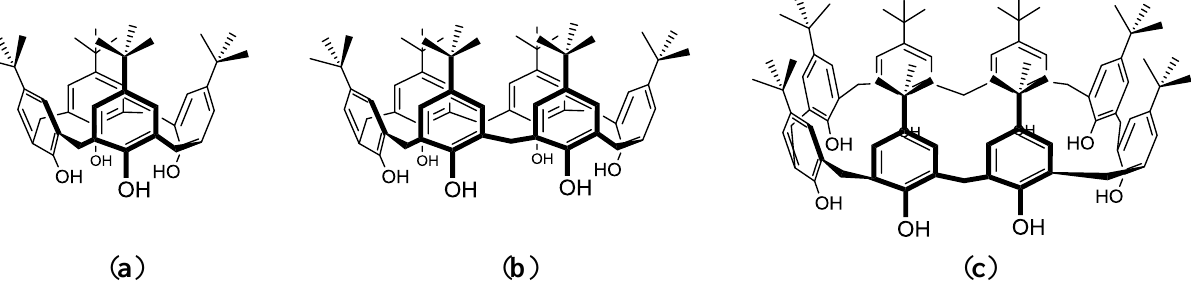
Figure 1. Structures of tert -butylcalix[ n ]arenes. ( a ) n = 4; ( b ) n = 6; ( c ) n =